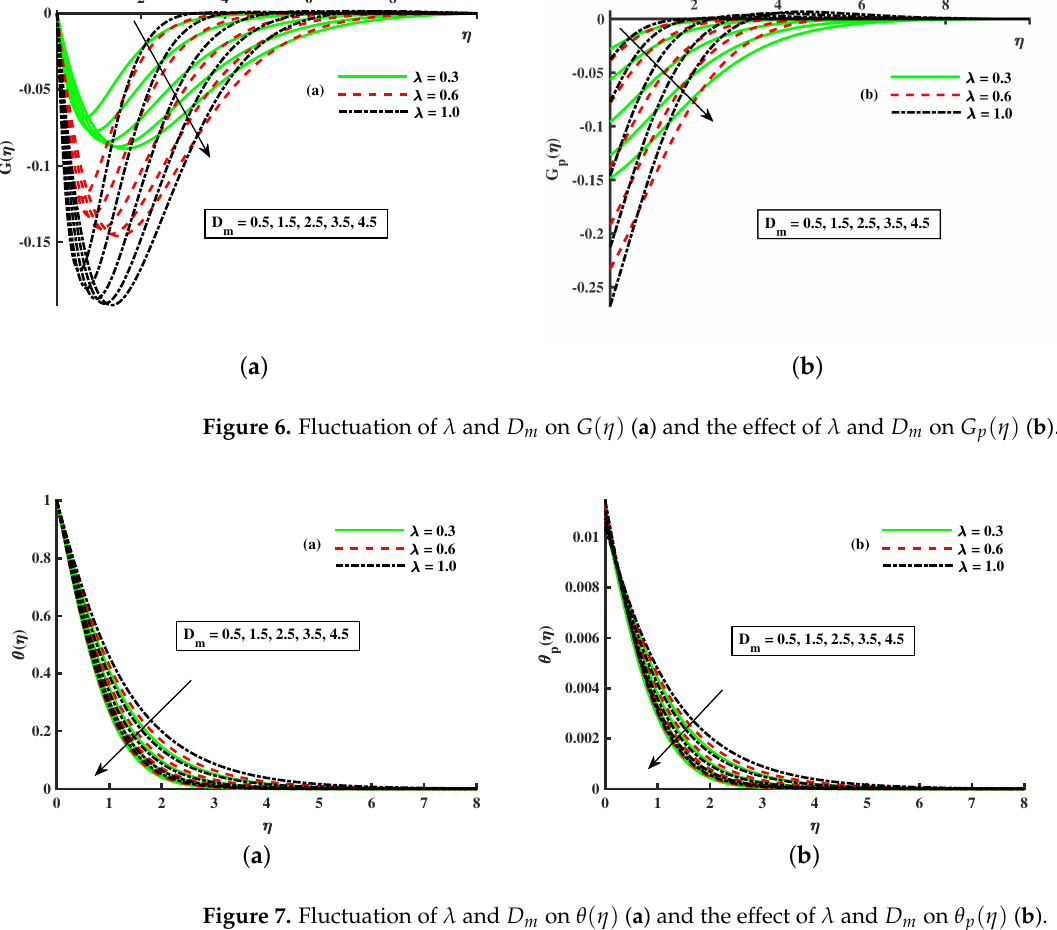
Figure 7. Fluctuation of λ and D m on θ ( η ) ( a ) and the effect of λ and D m on θ p ( η ) ( b ).